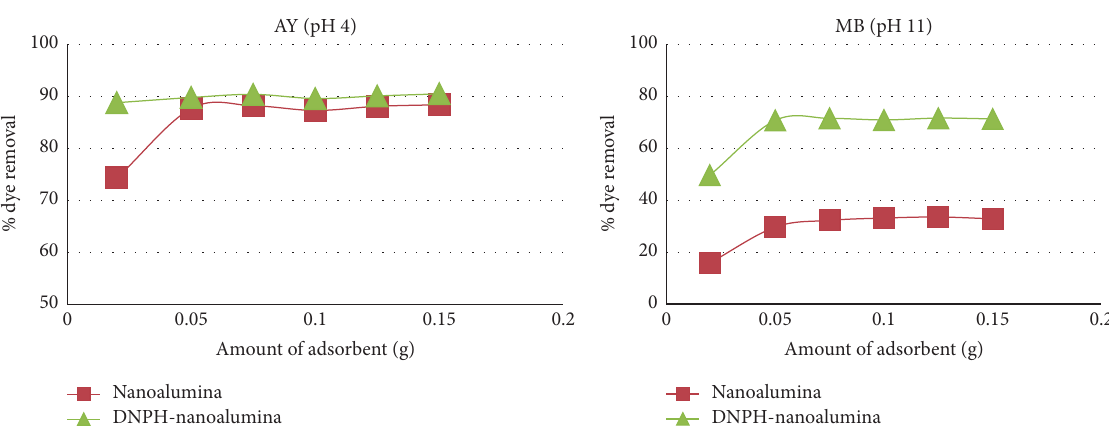
Figure 9: The effect of amount of adsorbent on the removal of the dyes, 50mg/L dye concentration, 90 min, and 298 K.